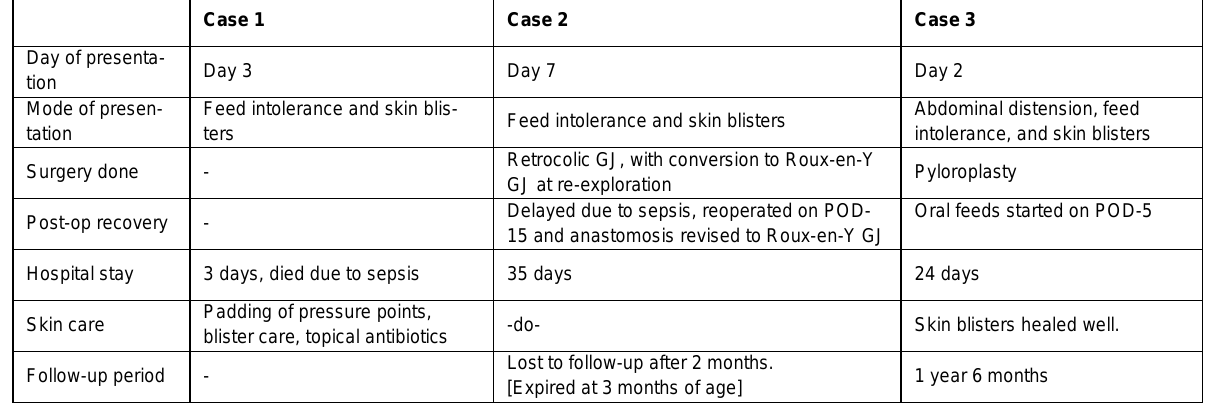
Table 1: Tabular presentation of reported 3 cases of Carmi